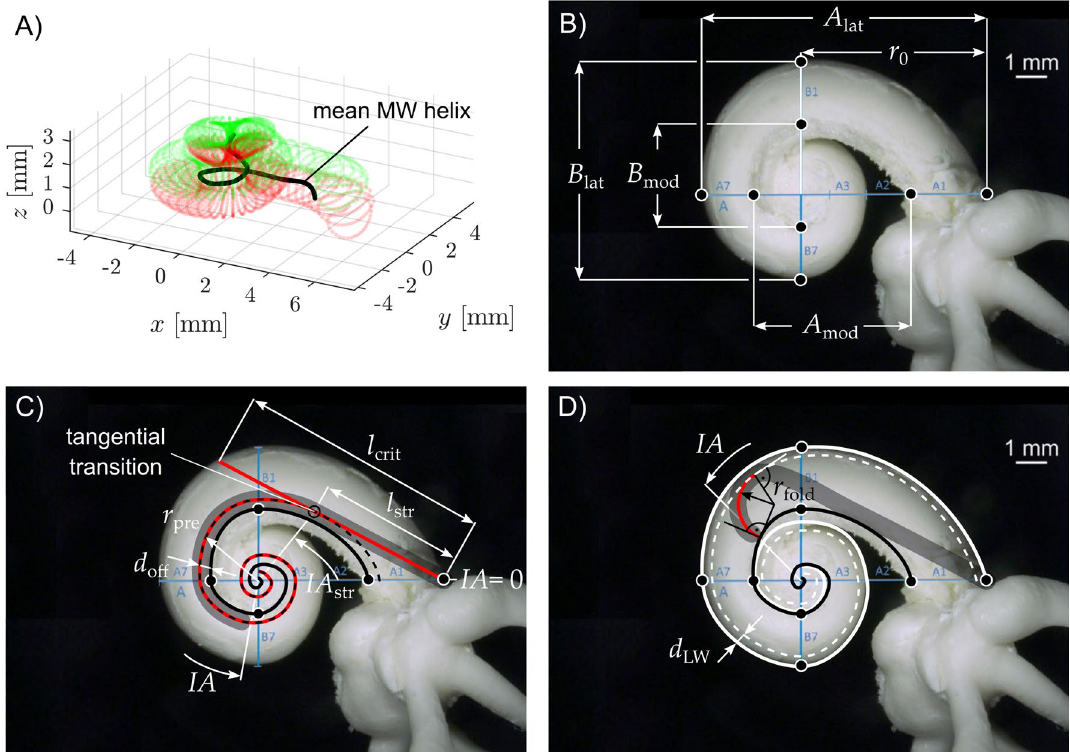
Figure 2. The methodological approach. ( A ) The average 3D profile of the cochlear MW extracted from the 15 µCT segmentations described in Ref. 37 . ( B ) Base axial view (see methods) at a left cochlea. Depiction of the cochlear dimensions A and B along the cochlear lateral (A lat , B lat ) and modiolar wall as well as the distance r 0 from the modiolar axis to the center of the round window. Please note that not all segments of the A and B axes are visible in this base axial view - for details see ref. 37 . ( C ) visualization of the computed insertion trajectory (in red) based on the individualized MW profile (solid black line) and distance d off between MW and central axis of a perimodiolar array. l str and IA str describe the distance and insertion angle respectively after which straight part of the insertion trajectory ends. r pre describes the curvature of the trajectory after the straight section. l crit represents the distance at which the insertion of a straightened array would touch the lateral wall and potentially cause damage. ( D ) The computations of the critical radii (r fold ) were based on the assumption that if the radius of the precurved implant is small enough for the tip to “stand up” inside the scala tympani, a tip fold-over becomes likely. For this reason, such hypothetical critical radius was computed depending on the different modiolar dimensions and different insertion angles (IAs). The minimal distance between the lateral wall and the central axis of an inserted array was denoted d LW